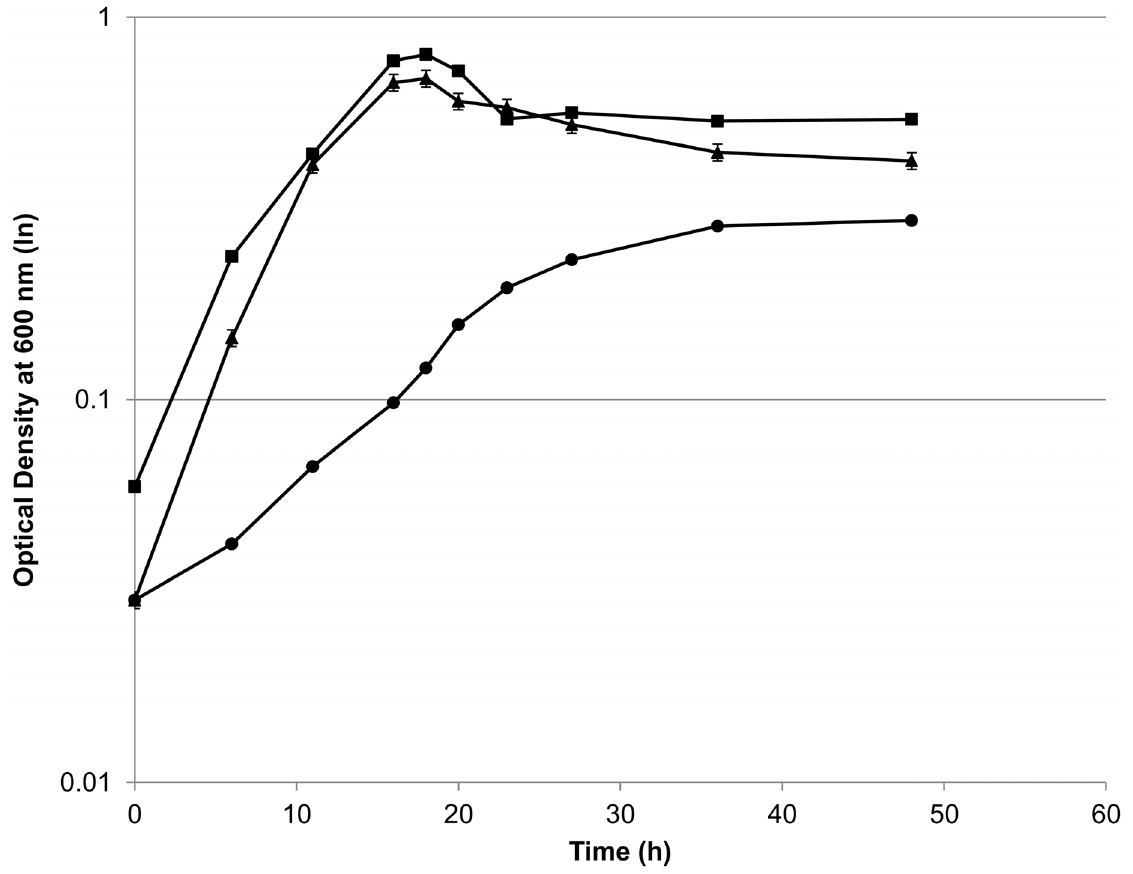
Figure 4. Growth profile of C.thermocellum mutants on minimal medium. Symbols: closed square, C. thermocellum wild type; closed circle, C. thermocellum adhE* (EA); closed triangle, C. thermocellum adhE* (EA) D ldh .